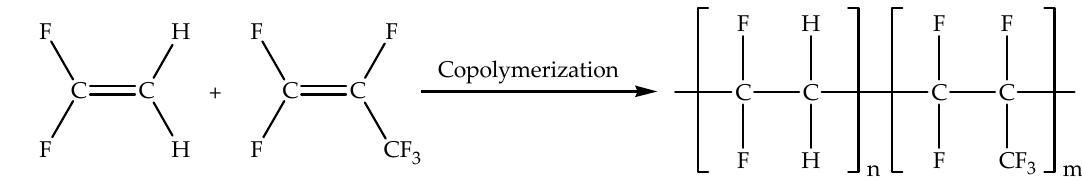
Figure 2. Schematic of the copolymerization of vinylidene fluoride with hexafluoropropylene to make PVDF-HFP.